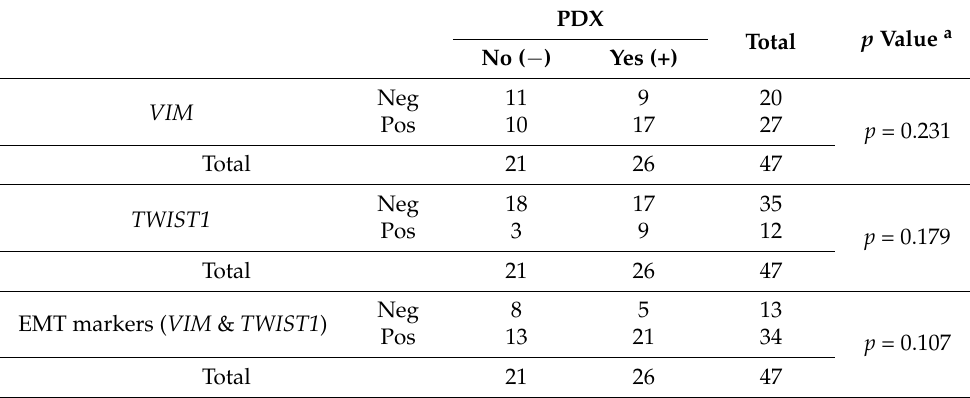
Table 3. CTCs expressing EMT markers and the grafting